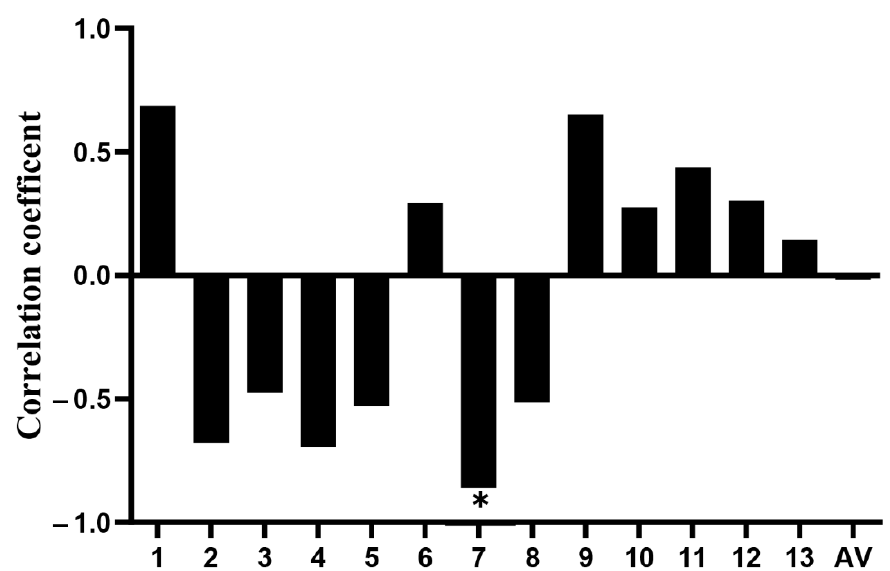
Figure 4. Effect of mC-7 site mutation on luciferase activity of the CXCL11 gene promoter. Mock: empty plasmid pGL3-Basic; MUT: recombinant plasmid treated with mutation of the mC-7 site (pGL3-Basic-MUT). WT: recombinant plasmid not treated with the original sequence of the mC-7 site (pGL3-Basic-WT). The promoter sequence that was examined was present in both the MUT group and the WT group. ** p < 0.01.